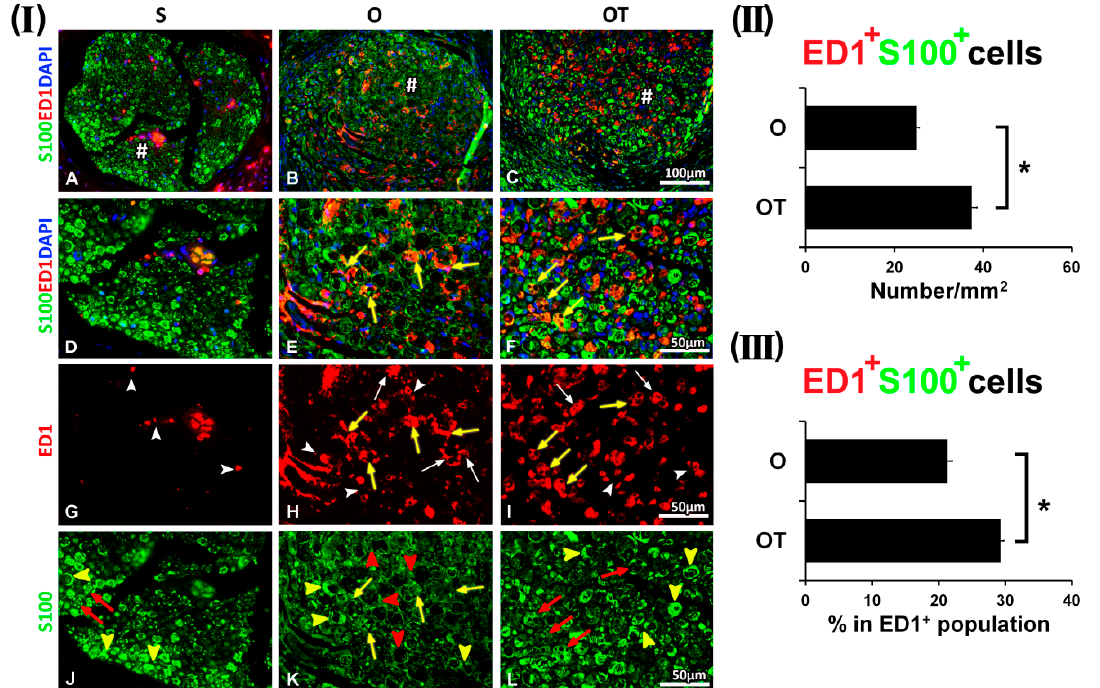
Figure 3. Effect of PNI and the treatment with B vitamins on SCs-macrophages co-localization at the 7th dpo. ( I ) Cross sections of femoral nerve obtained from the sham (S), operated (O, the transection of the motor branch) and operated and treated with the vitamin B complex (B1, B2, B3, B5, B6, and B12) (OT) groups were stained for ED1 (red), a marker of activated macrophages, anti-S100 antibody (green) as a marker of SCs, and counterstained with DAPI (blue) for visualizing cell nuclei. In the S group rare ED1 + cells were detected ( G , white arrow heads), while besides myelinating, mature SCs ( J , yellow arrow heads) some S100 + SCs of the non-myelinating morphology ( J , red arrows) were seen. No overlapping of ED1 and S100 immunoreactivity was noted ( A , D ). The representative images of the O and in the OT group revealed a huge number of ED1 + macrophages with the predominantly M2-like morphology and a few ED1 + macrophages with the M1-like morphology ( H and I , white arrows and white arrow heads, respectively). In the O group a widespread distribution of dark spots ( B , E , K ), consisting of faintly-stained SCs ( K , red arrow heads) and surrounded with many ED1 + / S100 + macrophages ( E and H , yellow arrows), was observed. Some of the macrophages that were only ED1 + had “foamy” morphology of the M2 type ( H , white arrows), while others were of the M1 type morphology ( H , white arrow heads). Seven consecutive injections of the vitamin B complex increased the number of ED1 + / S100 + cells ( F , yellow arrows), whereby ED1 + macrophages of the “foamy” morphology resembling the